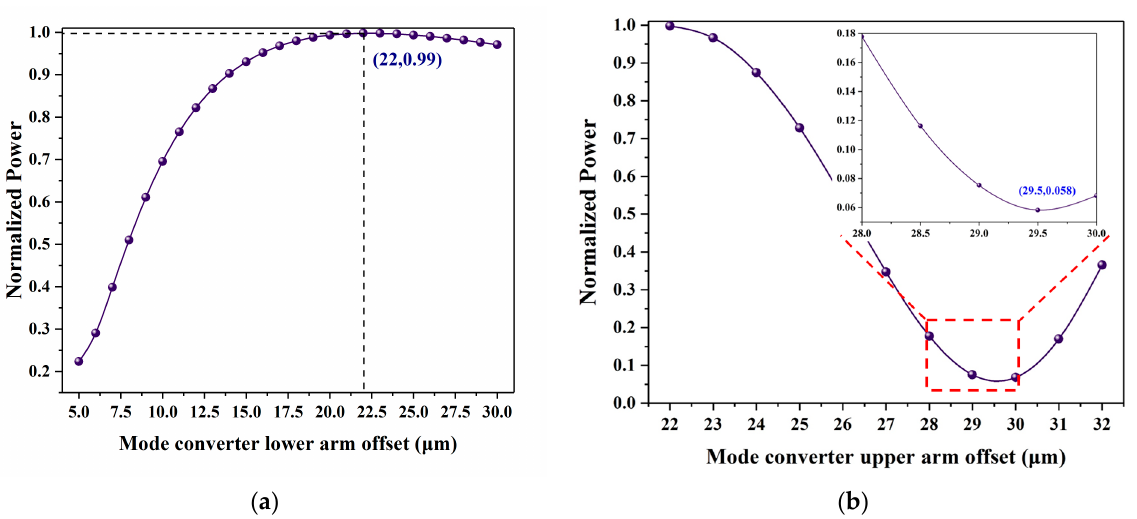
Figure 4. Scan results of the mode converter dimensions. ( a ) The normalized power as a function of mode converter lower arm offset; ( b ) the normalized power as a function of mode converter upper arm offset.